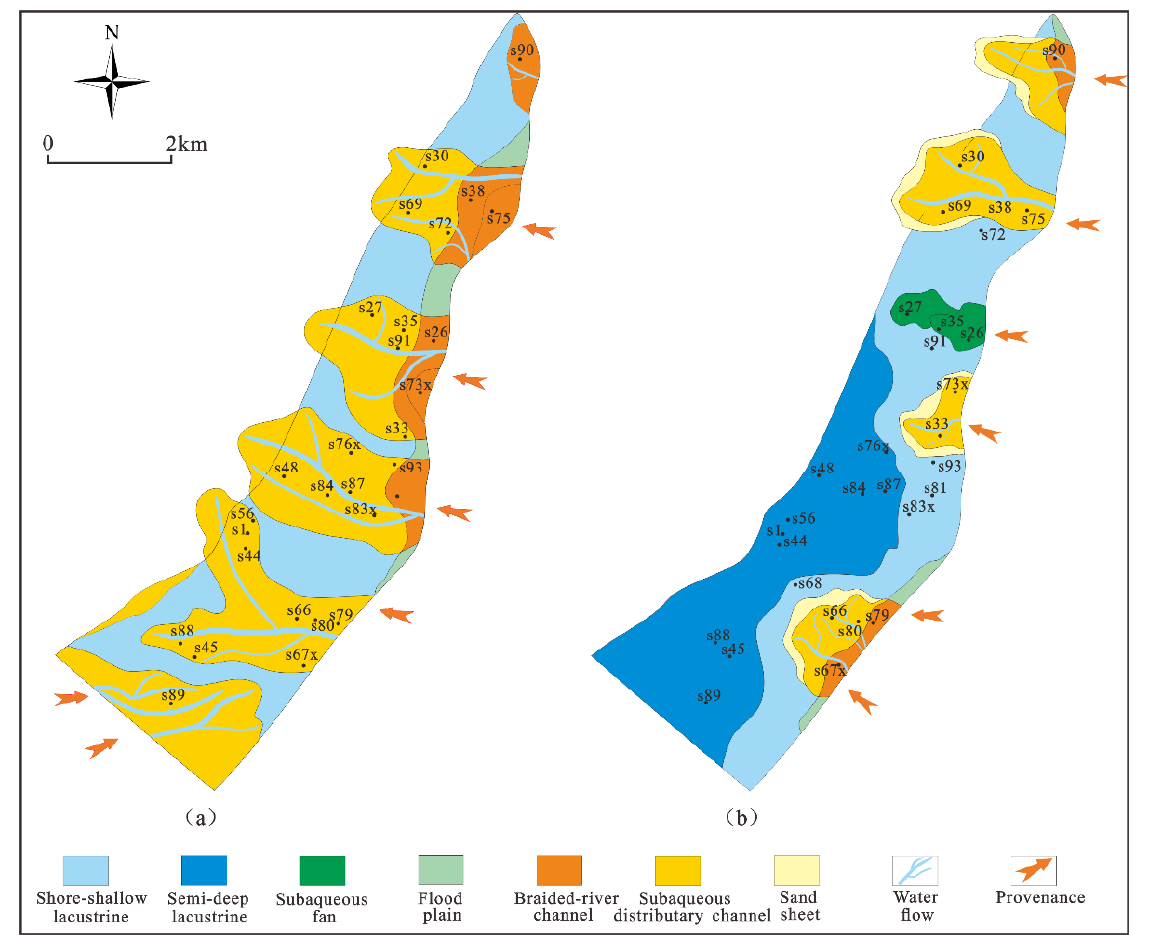
Figure 8. Planar distribution of sedimentary facies in Saidong sub-sag. ( a ) K 1 ba sedimentary period and ( b ) K 1 bt 1 sedimentary period.